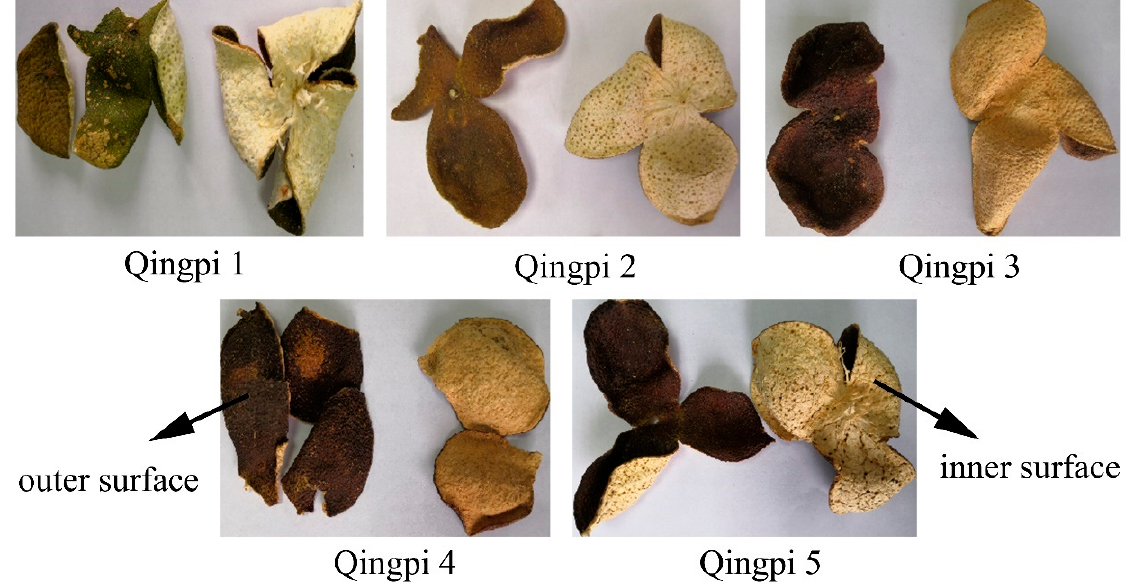
Figure 1. Colors of Qingpi 1, Qingpi 2, Qingpi 3, Qingpi 4, and Qingpi 5 samples during 1, 2, 3, 4, and 5 years of storage,